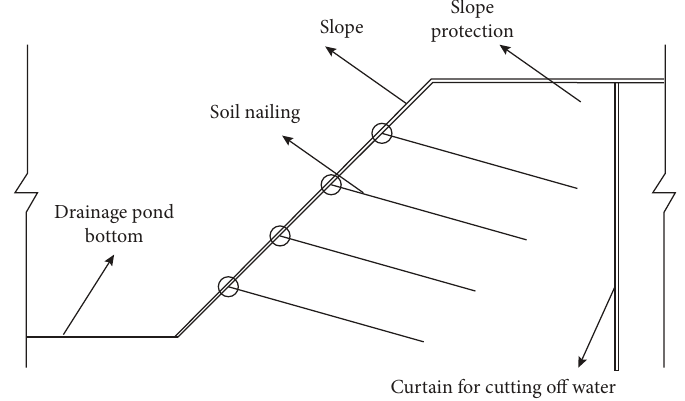
Figure 8: Structural diagram of boat pond deformation prevention under mining subsidence.